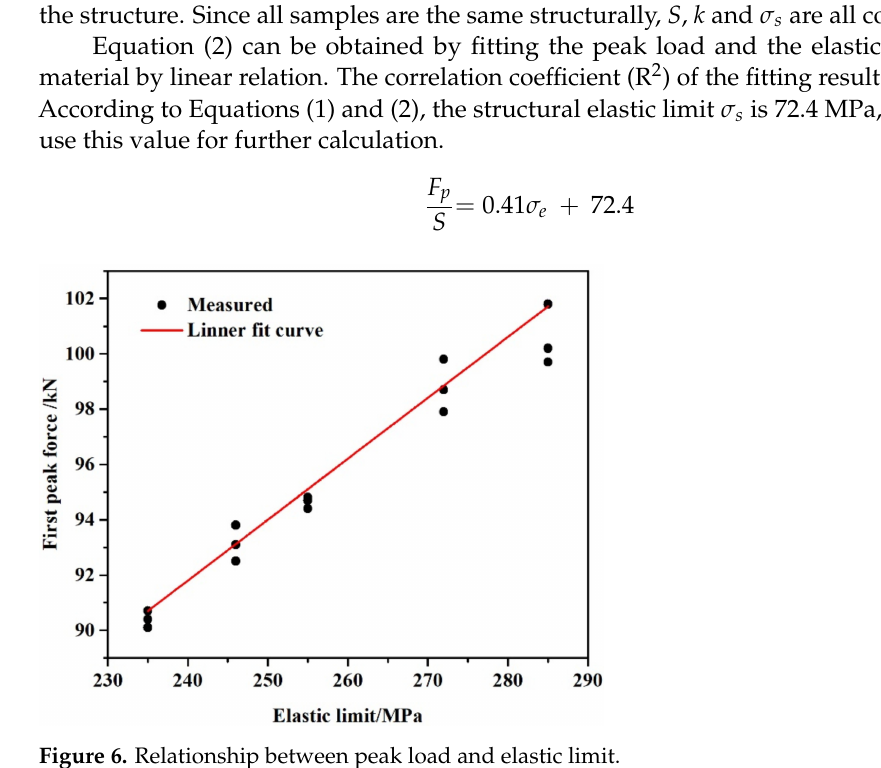
Figure 6. Relationship between peak load and elastic